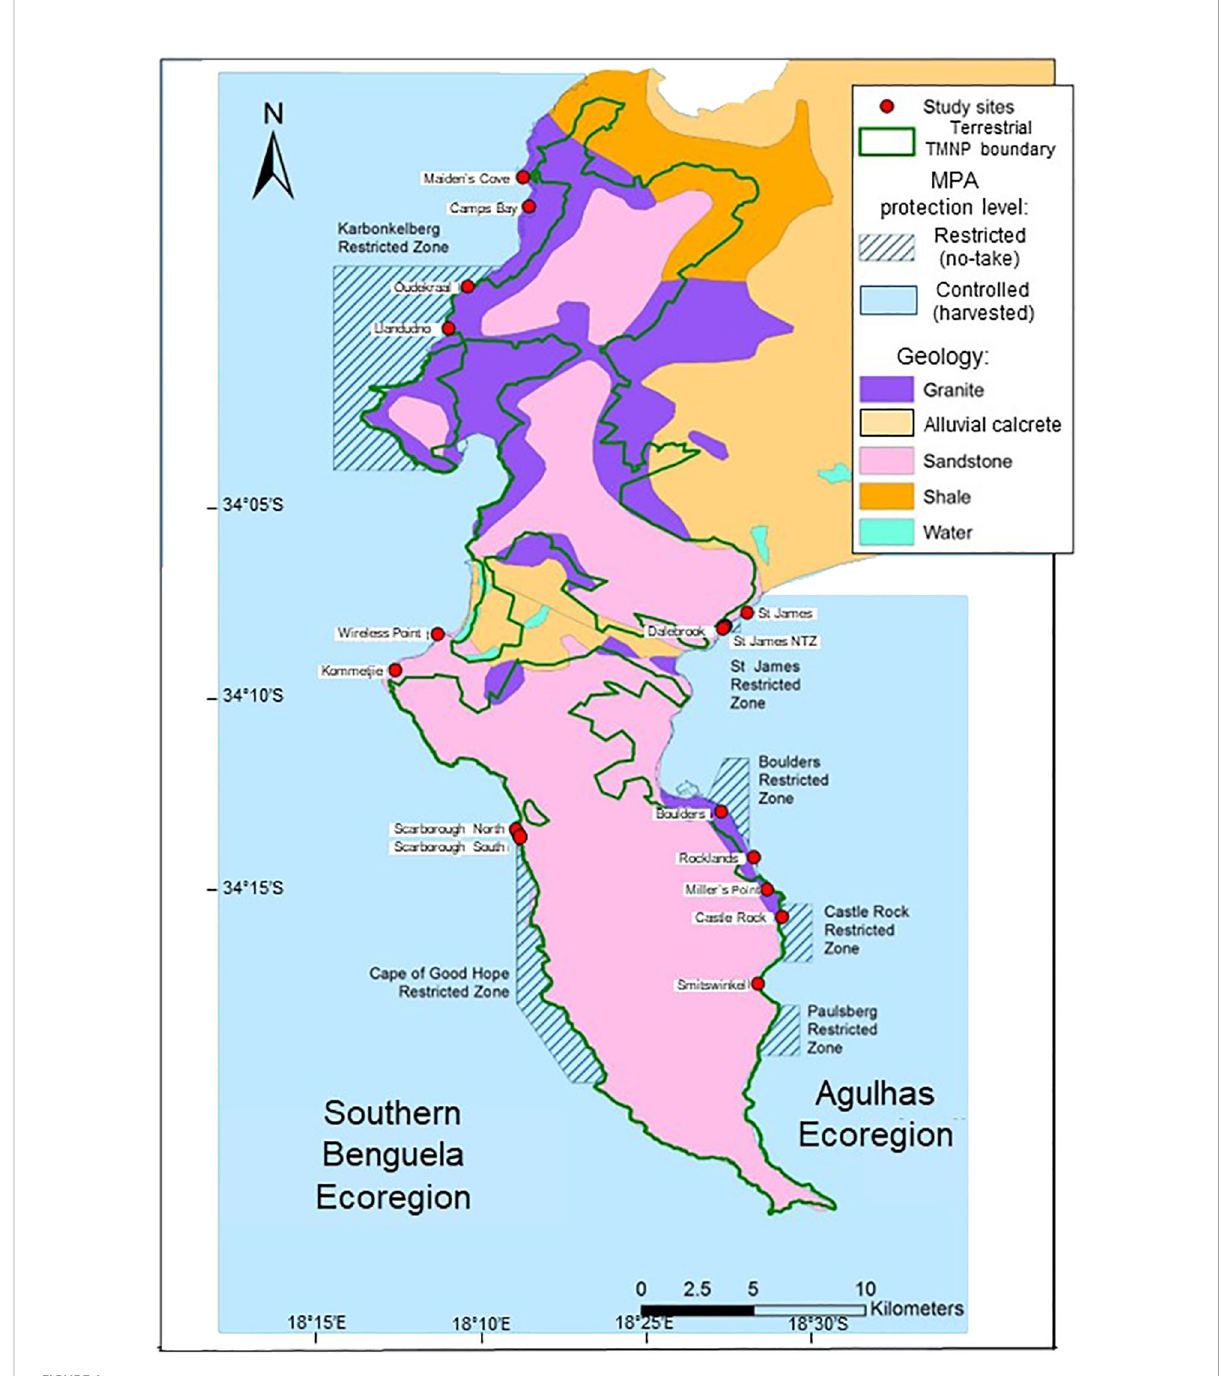
FIGURE 1 Map of the Cape Peninsula showing the Table Mountain National Park Marine Protected Area (TMNP MPA), with Controlled zones where harvesting is permitted (blue unmarked areas) and Restricted ‘ no-take ’ zones (blue hatched areas). Study sites are marked with red dots, and colour coding of the land indicates different geological